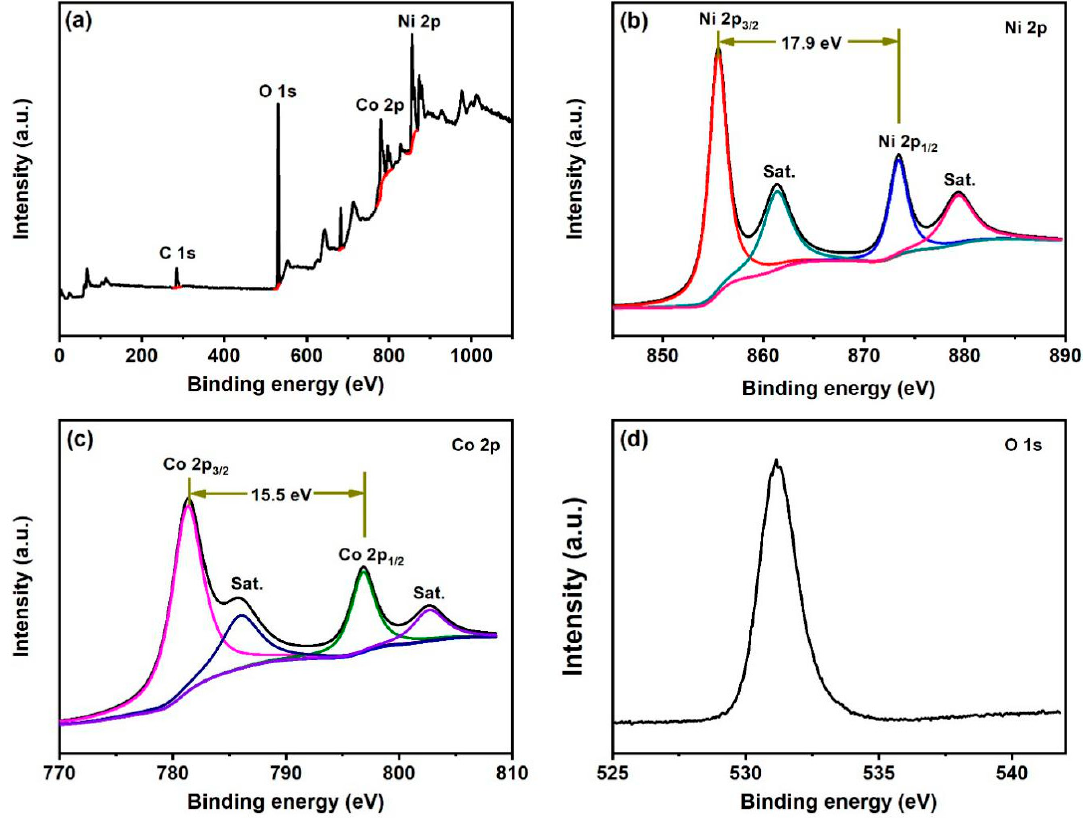
Figure 3. X-ray photoelectron spectroscopy (XPS) spectra of the Ni 0.5 Co 0.5 (OH) 2 : ( a ) survey spectrum; ( b ) Ni 2p; ( c ) Co 2p; ( d ) O 1s.